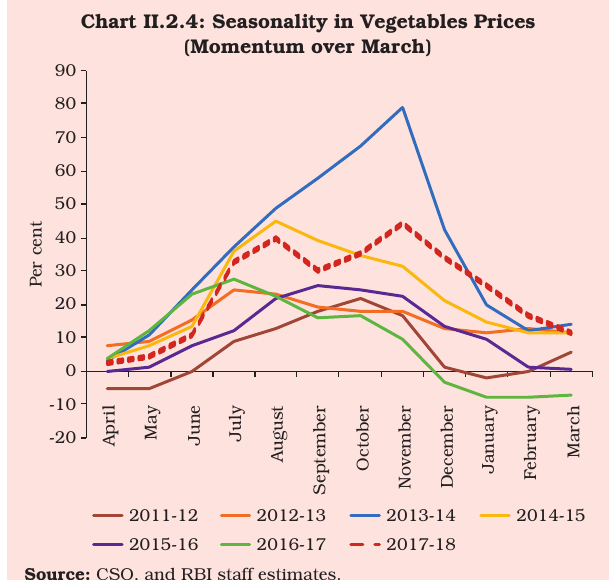
Chart II.2.4: Seasonality in Vegetables Prices (Momentum over